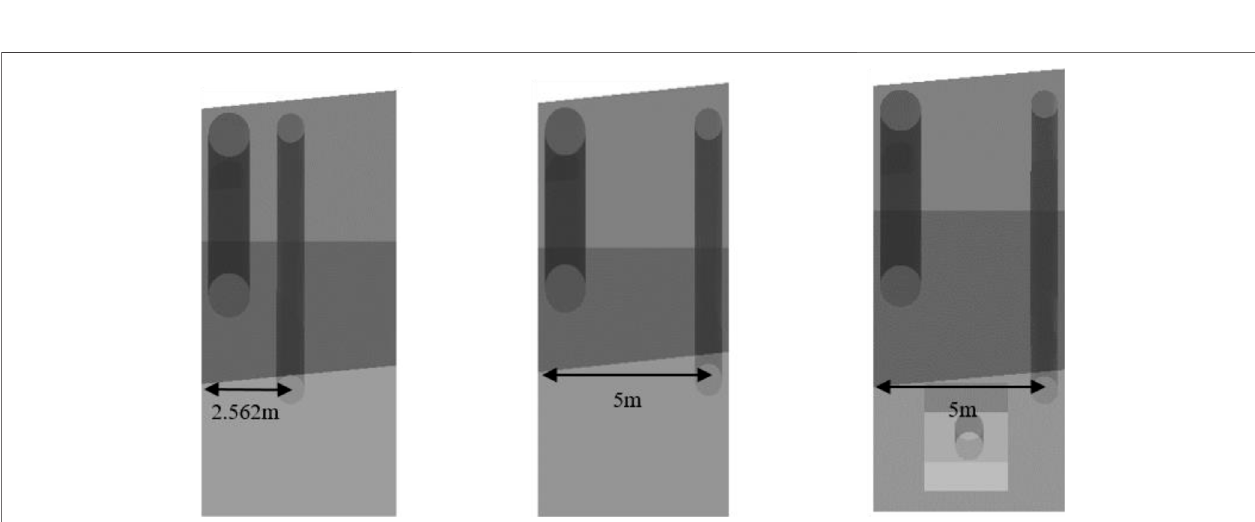
FIGURE 8 | Physical model for different dedusting-air duct positions.